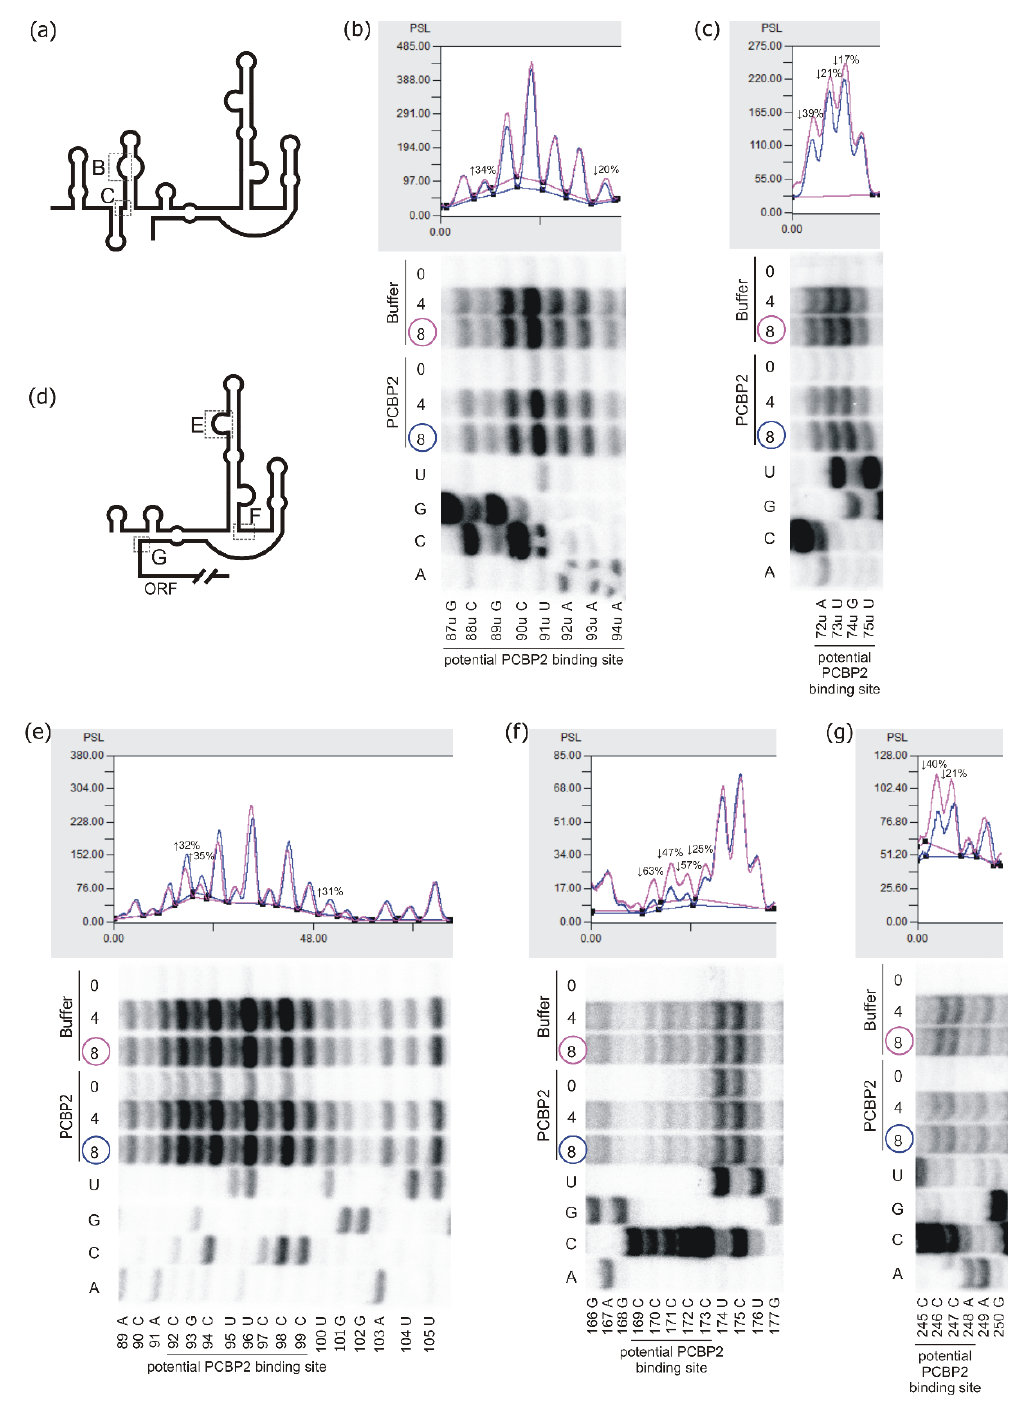
Figure 5. Structural analysis of the P0- Δ 40p53 RNA and p53-554 RNA in the presence of PCBP2 using Pb2+-induced cleavage method. Schematic representation of the secondary structure model of P0- Δ 40p53 RNA ( a ) and p53-554 RNA ( d ). The analysed regions to which PCBP2 binds are marked with dotted-line boxes B, C, E, F and G. ( b , c , e – g ) bottom panels: the autoradiograms show the products of Pb2+-induced cleavage reaction identified by reverse transcription method with 5 ′ -end-[32P]-labelled DNA primers. Pb2+-induced cleavage reaction was conducted in the presence of PCBP2 protein or the buffer, at 37°C for 3 minutes with Pb2+ ion concentration of 4 mM and 8 mM. Reaction products were separated on 12% polyacrylamide denaturing gels. Sequencing lines are marked A, C, G and U, respectively. Selected nucleotide residues are indicated on the left side of each autoradiogram. Black lines along the gels indicate potential PCBP2 binding sites. Upper panels: normalised reactivities for Pb2+-induced cleavage at Pb2+ ions concentration of 8 mM as a function of nucleotide position.